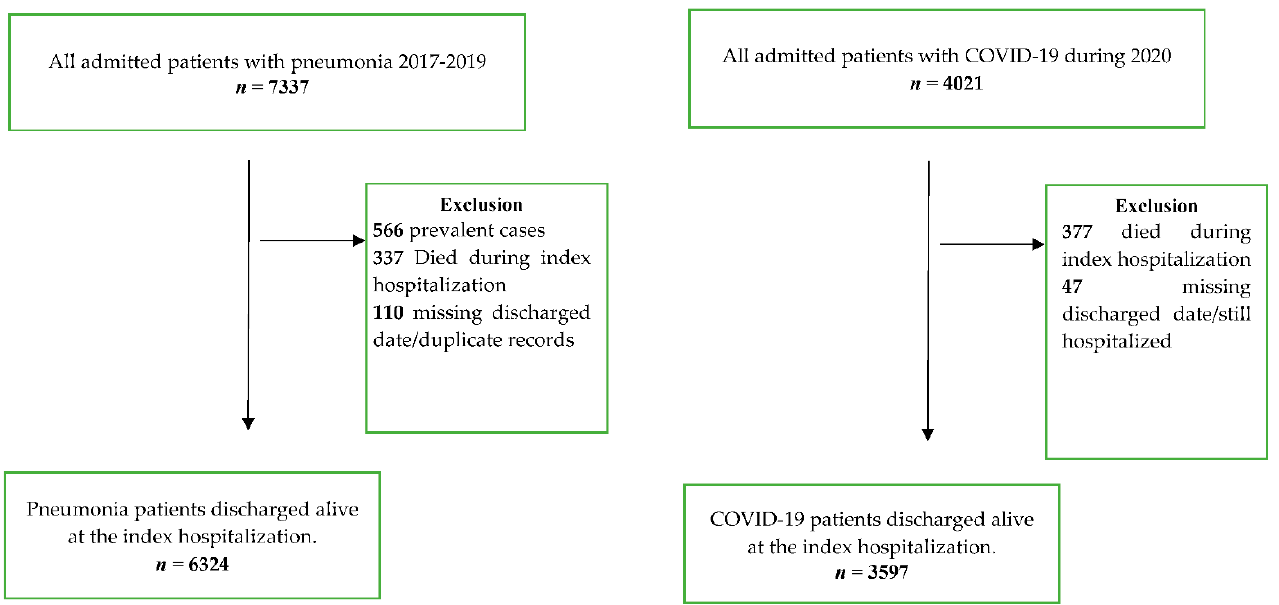
Figure 1. Flow diagram of the study population.